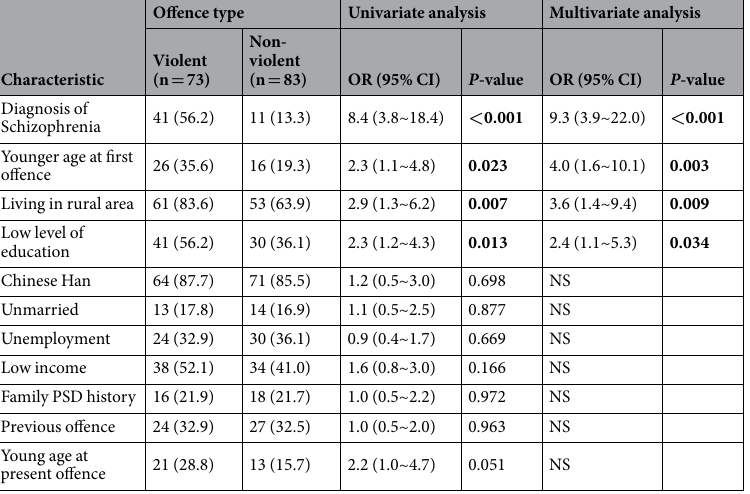
Table 2. Univariate and multivariate analyses for violent offence (n, %). Bolded values: < 0.05; PSD: psychiatric disorders; PSM: propensity score matching; NS: not significant in the final model.